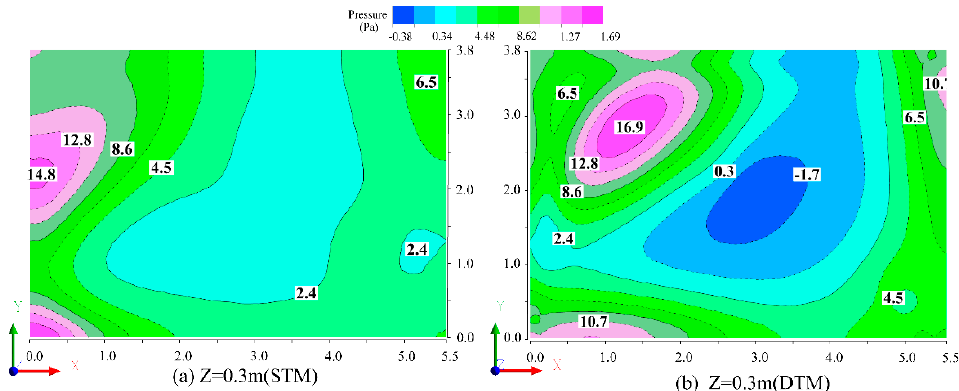
Figure 9. Pressure nephogram in Z = 0.3 m section under dynamic and stationary conditions.